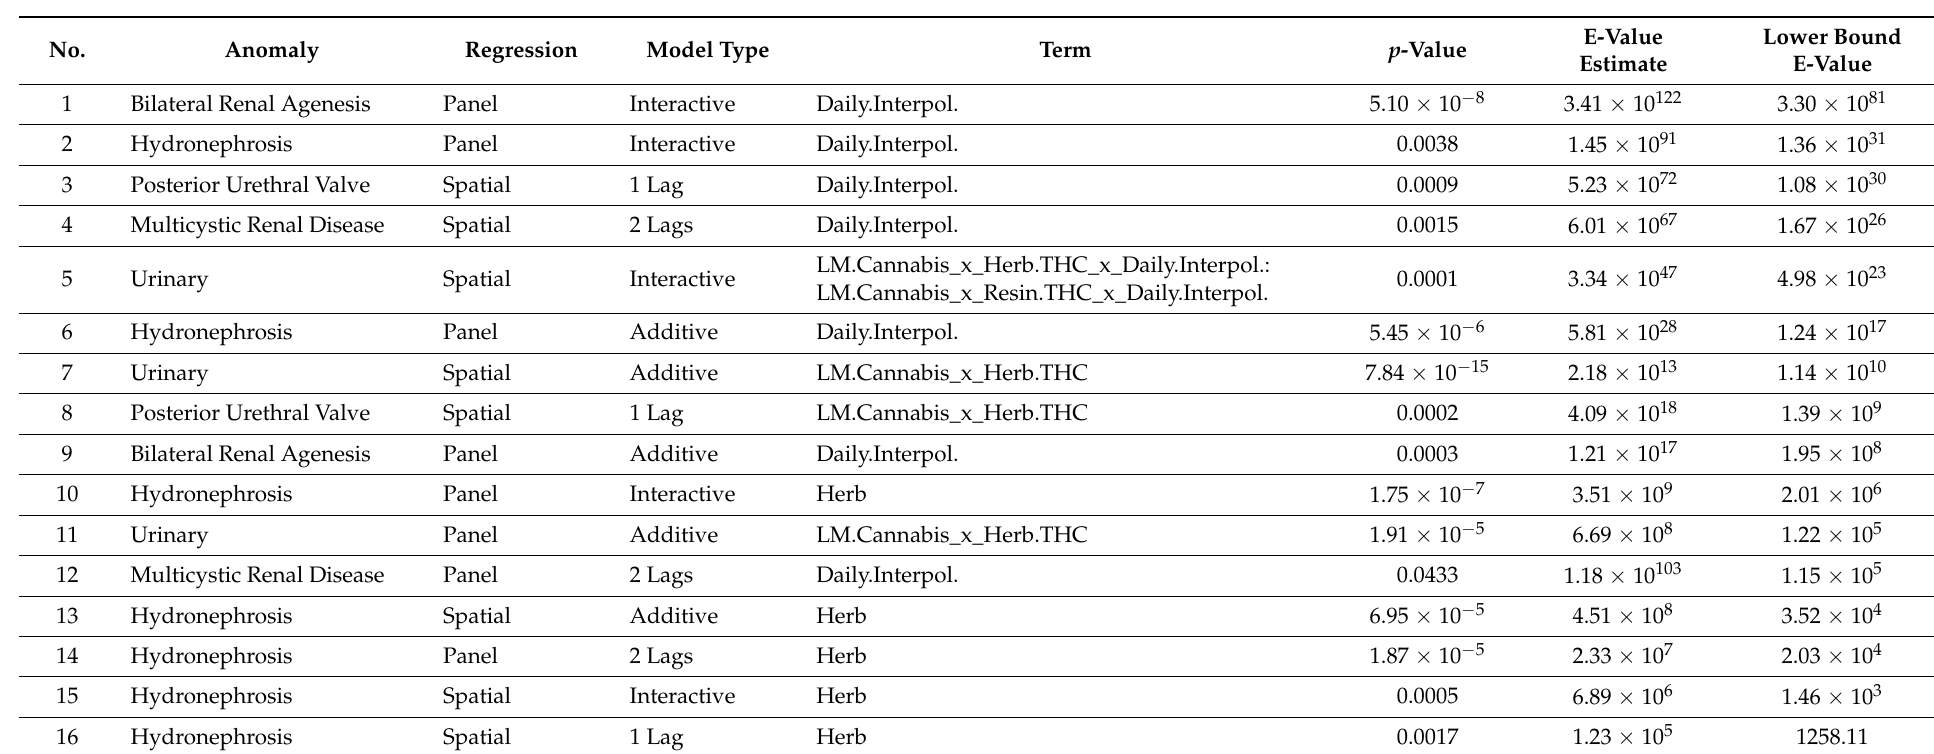
Table 9. All E-Values Ordered by Minimum